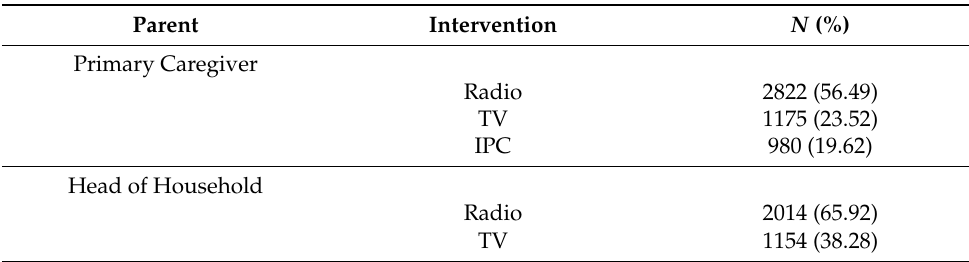
Table 2. Participants Exposed to Radio, TV, and IPC